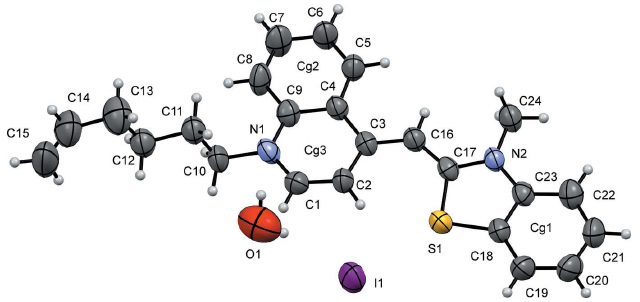
Figure 1 A view of the title compound, showing the atom labeling. Displacement ellipsoids are drawn at the 50% probability